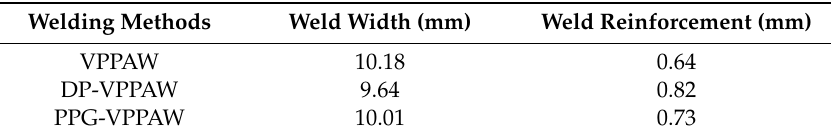
Figure 13. Macrographs of cross-section and the distribution of pores in weld fusion line region. ( a ) Macrographs of cross-section; ( b ) the distribution of pores in weld fusion line region. Table 4. The weld reinforcement and width.